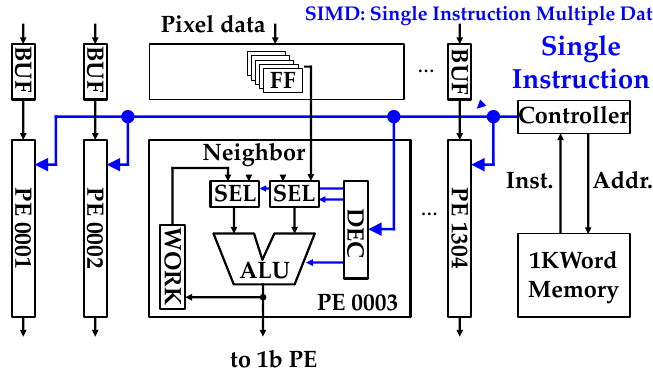
Figure 6. Column 4b PEs SIMD operation.